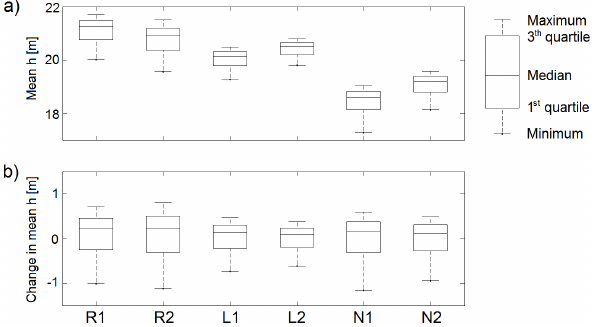
Figure 3. Based on results where each of the six hydrological mod- els are forced by 11 climate model projections: (a) box plot of the simulated mean hydraulic head, h , in the limestone aquifer in the focus area and (b) box plot of the change in h from reference to future scenarios.